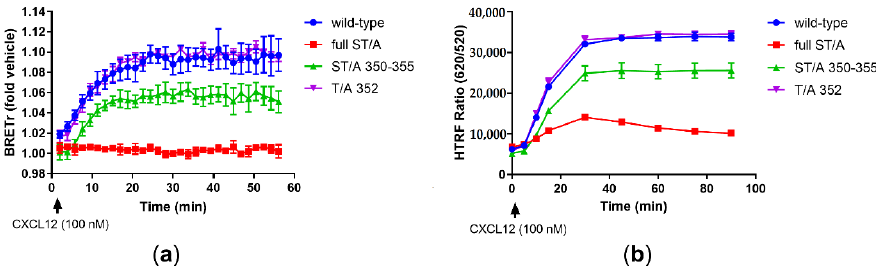
Figure 5. Agonist-induced internalization of ACKR3 wild-type and mutant receptors. ( a ) CXCL12-induced ACKR3 wild-type and mutant receptors translocation to Rab5a-Venus ACKR3 over time as measured by BRET in HEK293T cells; ( b ) CXCL12-mediated internalization of ACKR3 wild-type and mutant receptors over time as measured by TR-FRET in HEK293T cells. Representative curves of at least three independent experiments with triplicates shown as mean ± SD.